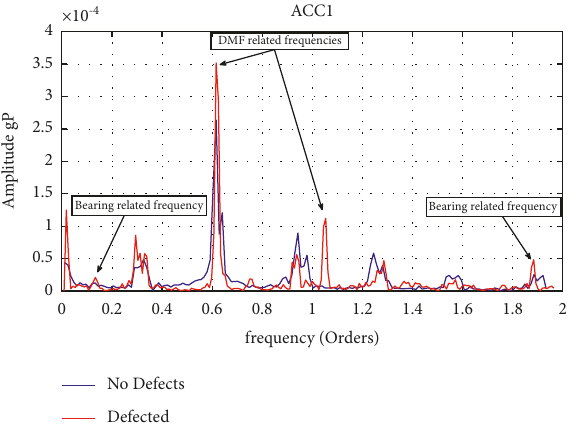
Figure 18: Cyclostationary with